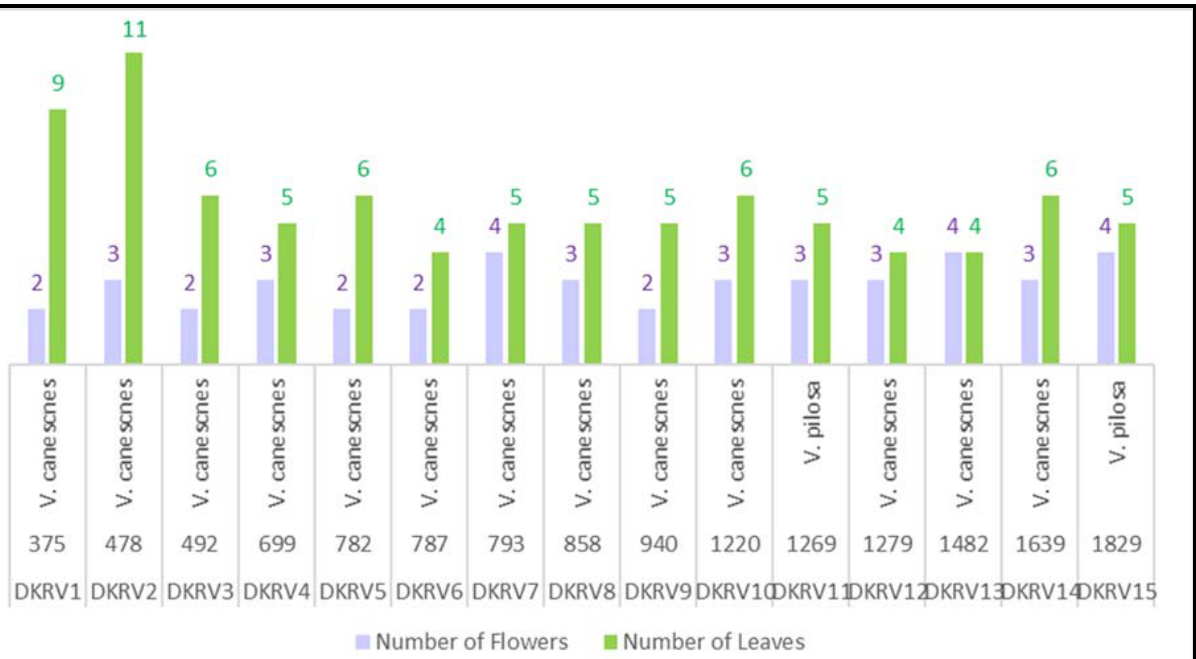
Figure 4. Leaf number variation at gradient altitudes of Viola species.